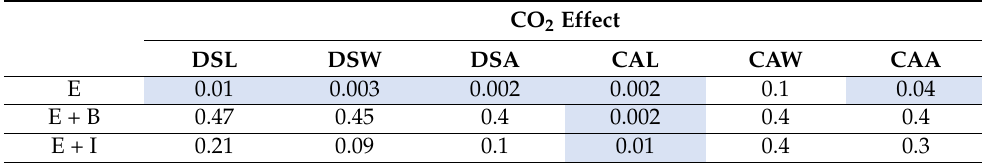
Table 3. Significance ( p value) of t -test comparing coccolith measures and carbon dioxide conditions. E. huxleyi (E) and E. huxleyi co-cultured with Brachybacterium sp. (E + B) and with I. abyssalis (E + I). CO 2 Effect DSL DSW DSA CAL CAW CAA E 0.01 0.003 0.002 0.002 0.1 0.04 E + B 0.47 0.45 0.4 0.002 0.4 0.4 E + I 0.21 0.09 0.1 0.01 0.4